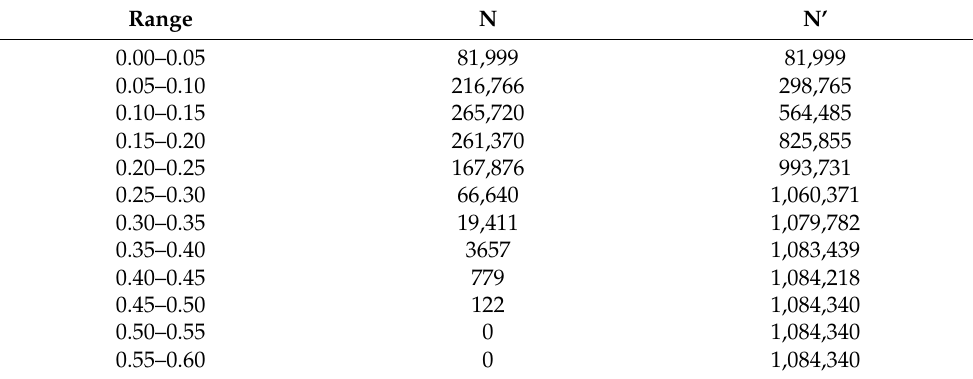
Table 6. Distribution of the orbital eccentricities of all the MB asteroids. N is the number of objects with eccentricity e in each range, while N’ is the number of objects with e less than or equal to the second extreme of each range. It should be noted that a non-negligible percentage of the entire population of the asteroidal MB, equal to 8%, has orbital eccentricities greater than 0.25. Data taken from the NASA/JPL Small-Body Database site.